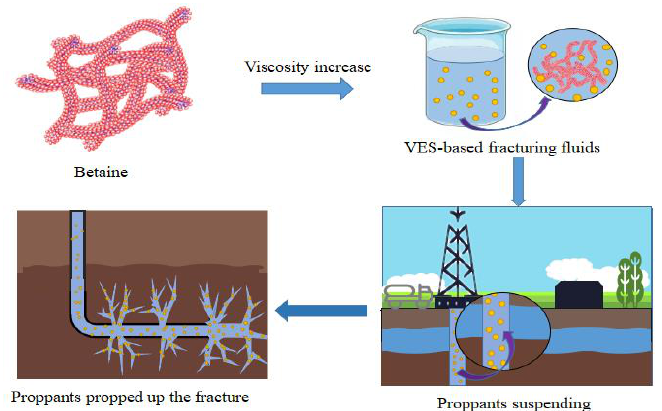
Figure 1. The preparation and application of VES-based fracturing fluid.